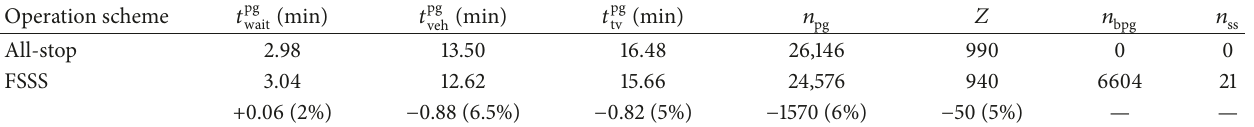
Table 4: Performance of all-stop operation and